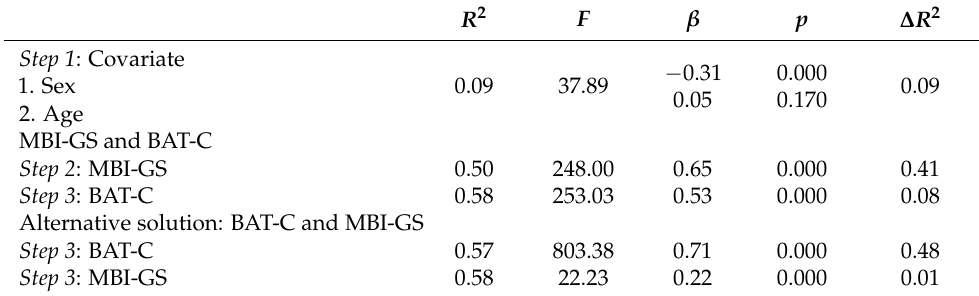
Table 7. Hierarchical multiple regression predicting burnout secondary symptoms (BAT-S). R 2 F